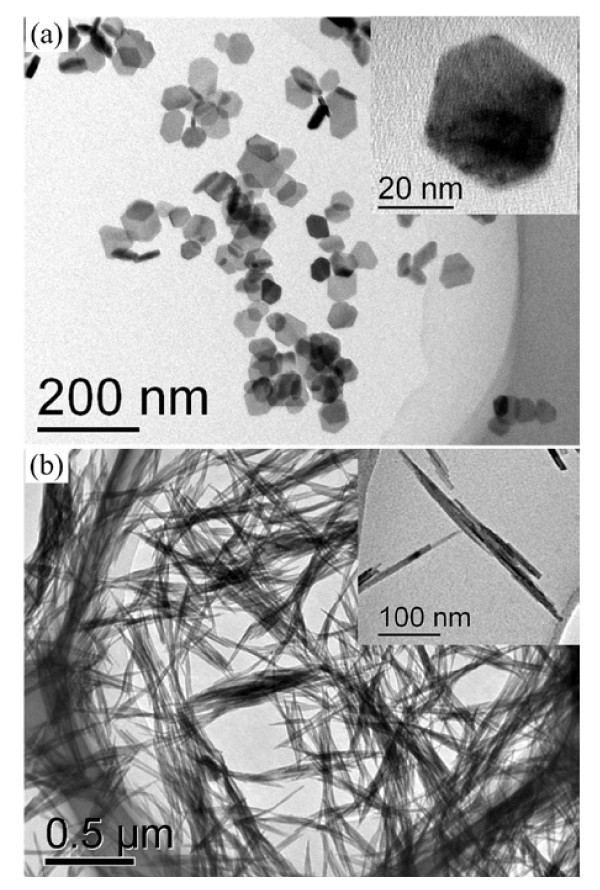
TEM images. TEM images of CeF3:Mn (a) and CePO4:Mn (b) NCs.